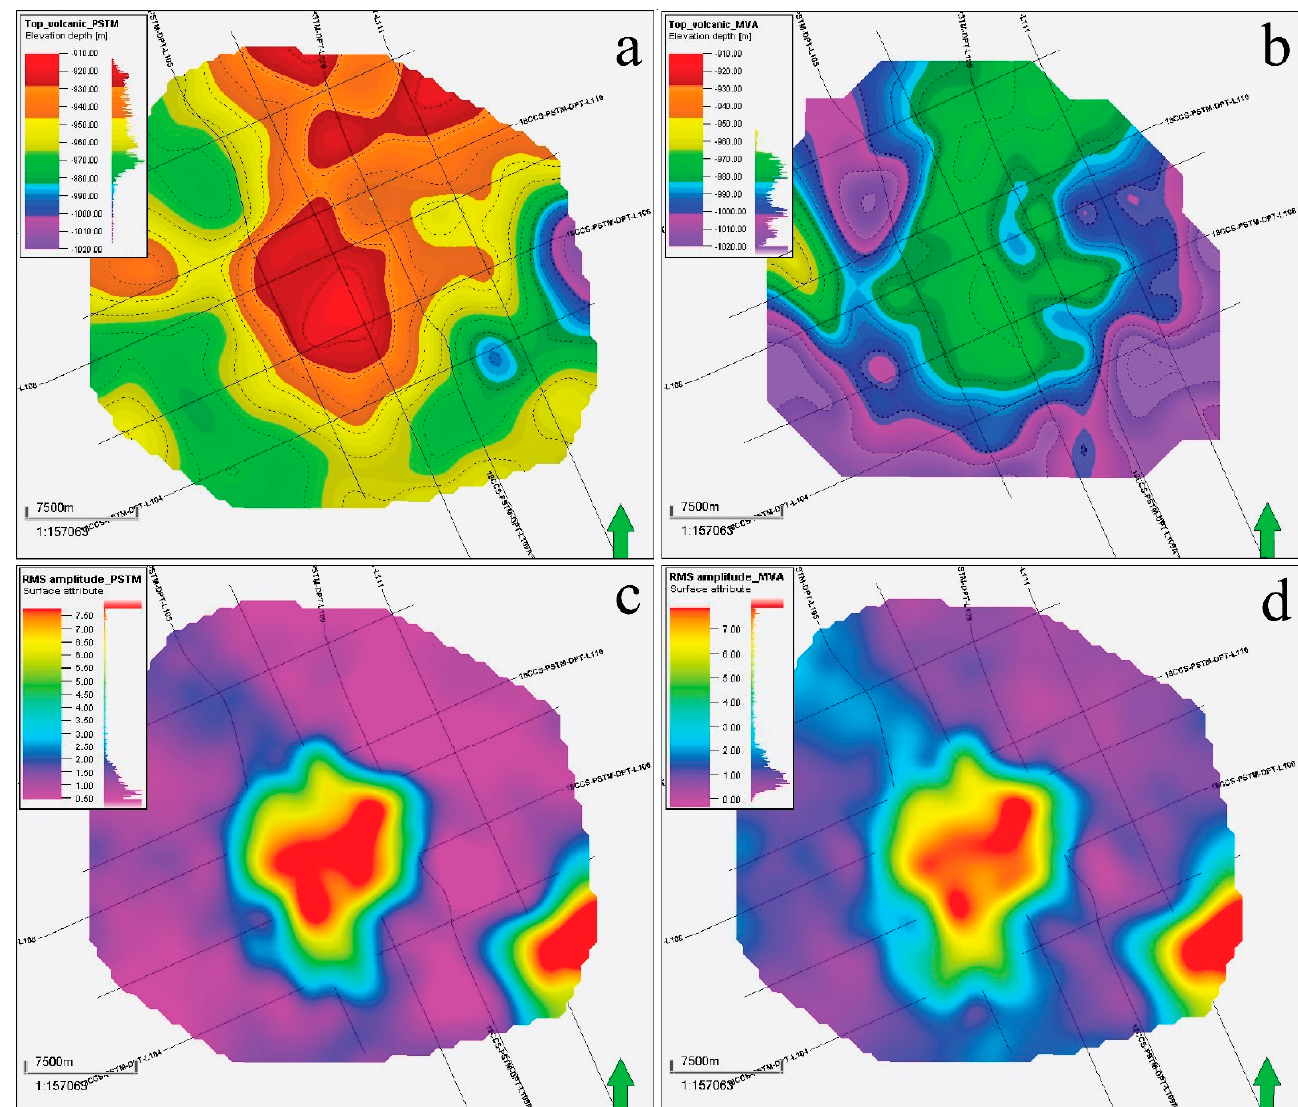
Figure 11. Contour maps of the strong reflector and RMS attributes. Geologically interpreted tops of the volcanic mounds ( a ) before and ( b ) after depth processing. RMS amplitude attributes ( c ) before and ( d ) after depth processing showing volcanic mounds’ anomalous region.